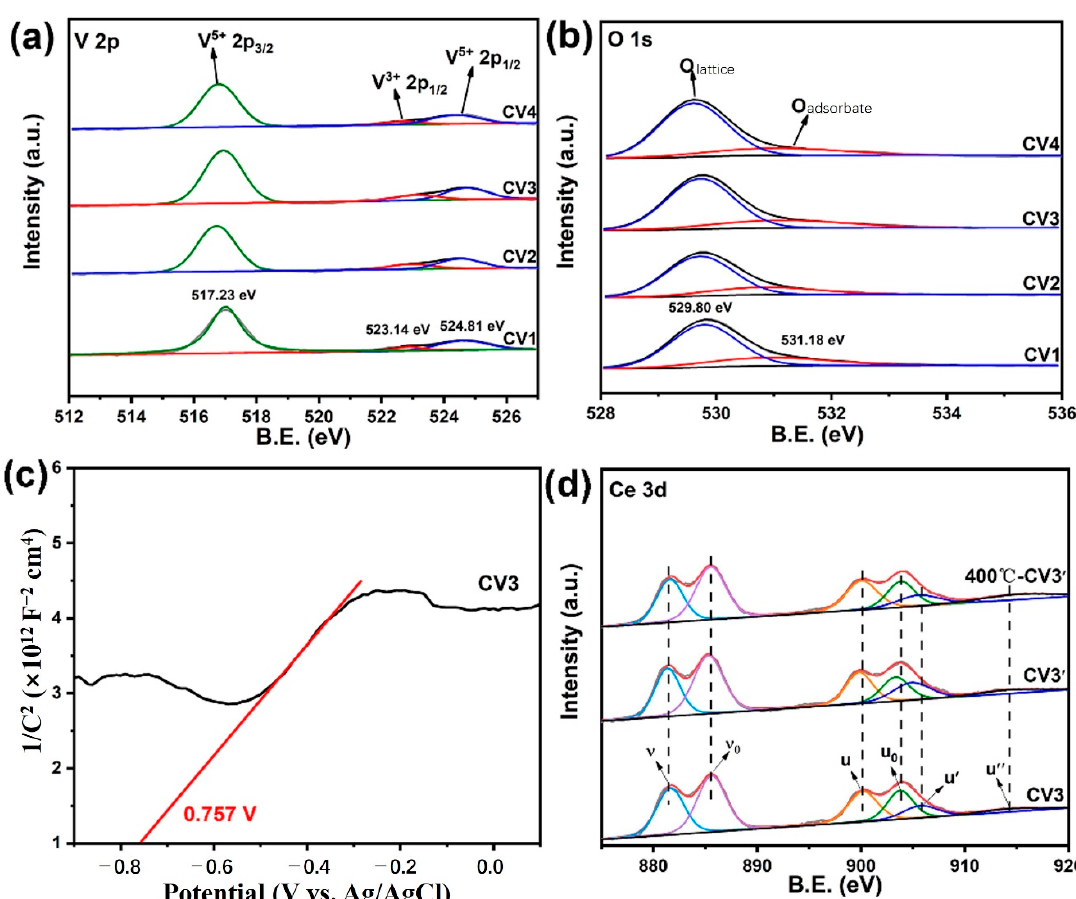
Figure 7. XPS spectra for CV1–4: ( a ) V element, ( b ) O element, ( c ) Mott-Schottky curve of CV3, ( d ) XPS spectra for CV3, CV3’ and 400 °C-CV3’.